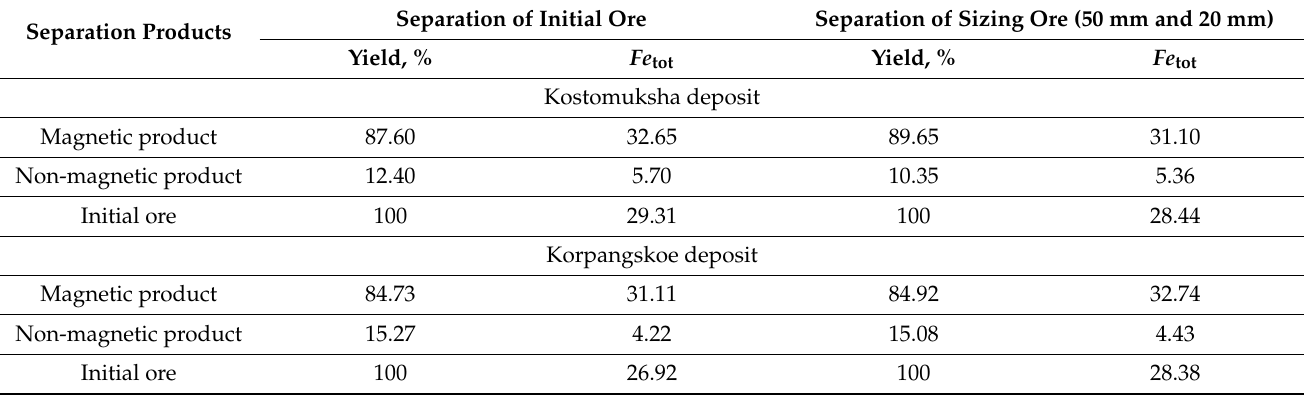
Table 7. Results of dry magnetic separation of iron ore samples, Kostomuksha and Korpangskoe deposits. Separation